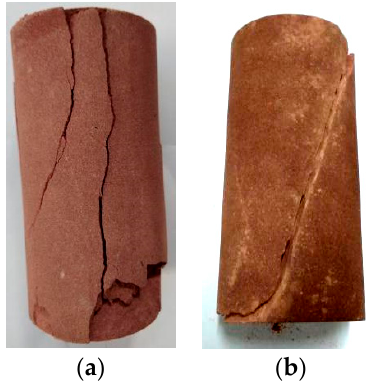
Figure 7. Failure modes of the red sandstone samples: ( a ) uniaxial compression; ( b ) triaxial com- pression.